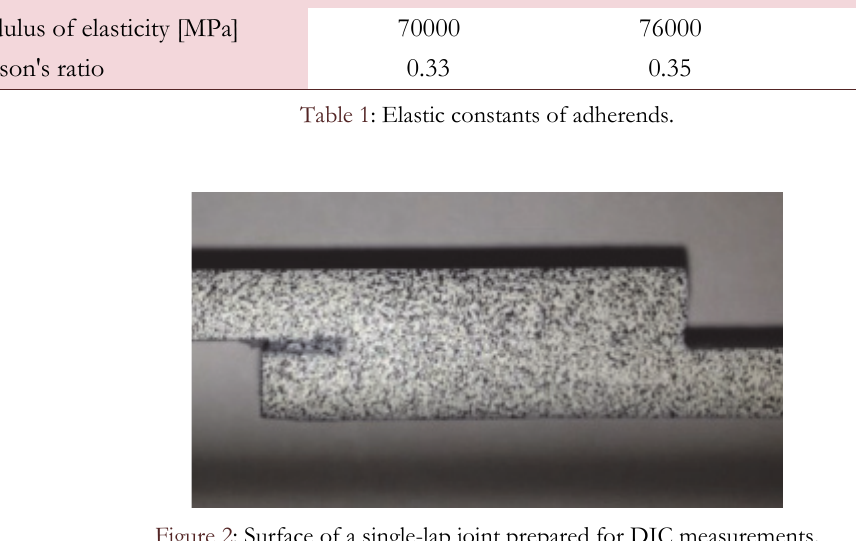
Figure 2: Surface of a single-lap joint prepared for DIC measurements.